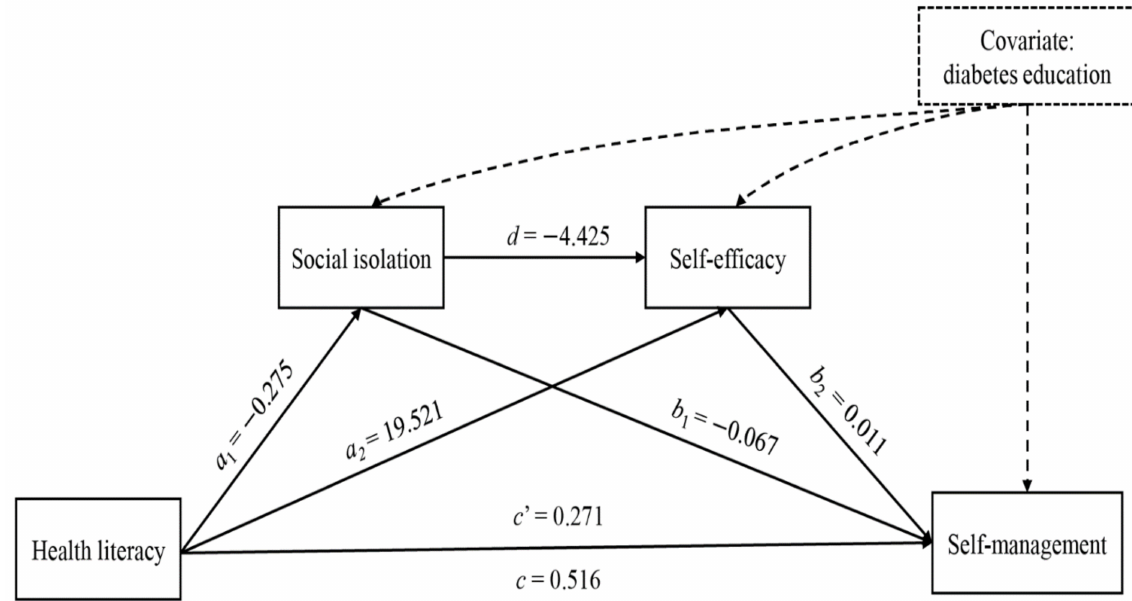
Figure 1. Mediation model linking health literacy with self-management while controlling for diabetes education. a 1 , regression coefficient of health literacy predicting social isolation while controlling for diabetes education; a 2 , regression coefficient of health literacy predicting self-efficacy while controlling for social isolation and diabetes education; b 1 , regression coefficient of social isolation predicting self-management while controlling for health literacy, self-efficacy, and diabetes education; b 2 , regression coefficient of self-efficacy predicting self-management while controlling for health literacy, social isolation, and diabetes education; c , total effect while controlling for diabetes education; c ’, regression coefficient of health literacy predicting self-management while controlling for social isolation, self-efficacy, and diabetes education; d , regression coefficient of social isolation predicting self-efficacy while controlling for health literacy and diabetes education. All coefficients were